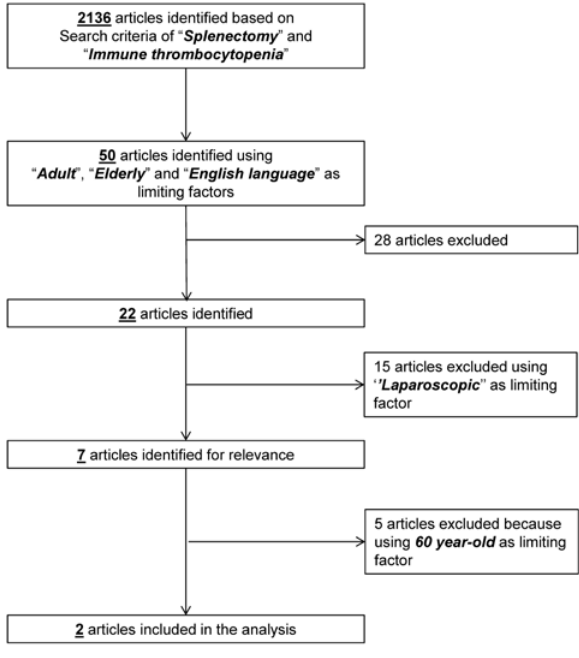
Figure 2: Flow diagram of search strategy